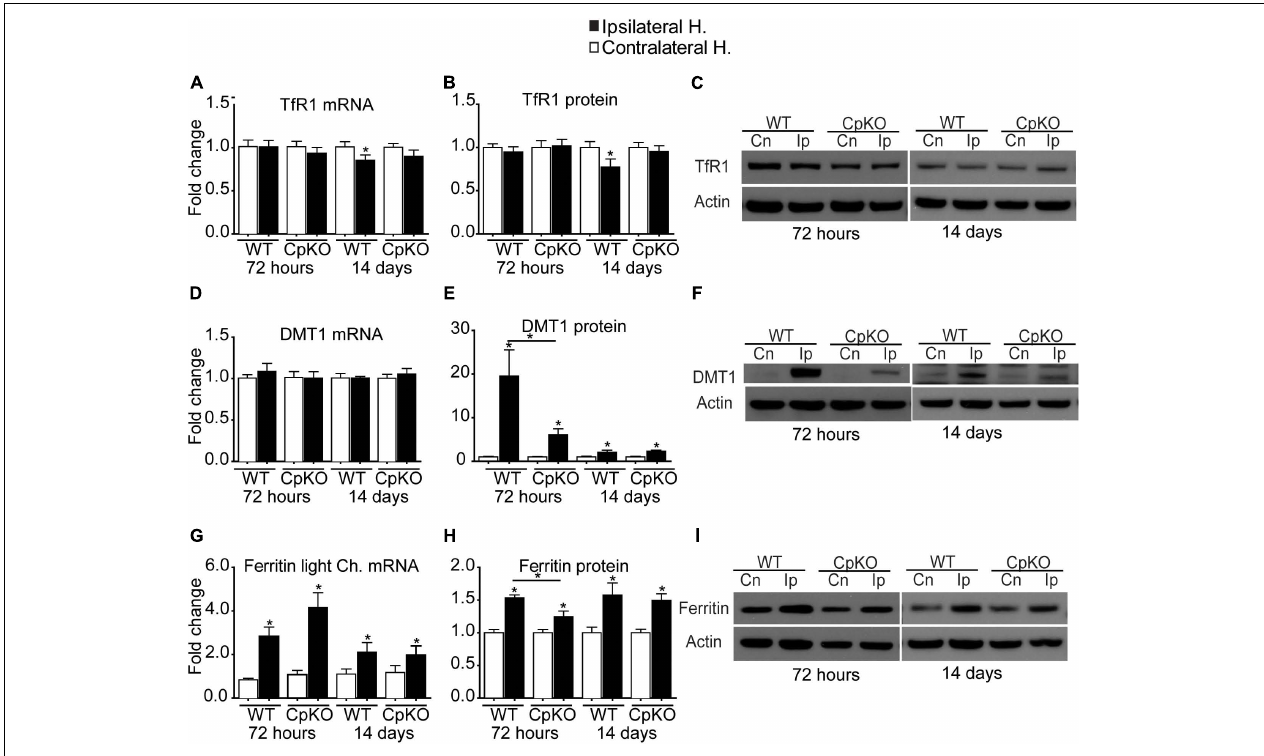
FIGURE 3 | Changes in mRNA and protein expression of TfR1 (A–C) , DMT1 (D–F) , and ferritin (G–I) shown as fold-change in the ipsilateral ischemic side as compared to the contralateral uninjured side at 72 h and 14 days after pMCAO. No changes are seen in TfR1 mRNA (A) or protein (B) except for a small but significant reduction in the ipsilateral side in wildtype mice at 14 days. Representative Western blot shown in C . Changes in expression of DMT1 mRNA (D) , and protein (E) quantified from Western blots; representative Western blot shown in F . Note the marked increase in DMT1 protein on the ipsilateral side in wildtype (19.5-fold) and Cp null (sixfold) mice at 72 h, which remain elevated at twofold at 14 days in both genotypes. Changes in mRNA expression of ferritin light chain (G) and ferritin protein (H) and a representative Western blot (I) . Note the increase in mRNA and protein levels in the ipsilateral side in all groups. β actin was used as a loading control; note that the same blot was used to probe DMT1 (F) and Cp ( Figure 2C ) hence the actin blots for these are the same. n = 6 per group; ∗ p -value ≤ 0.05.